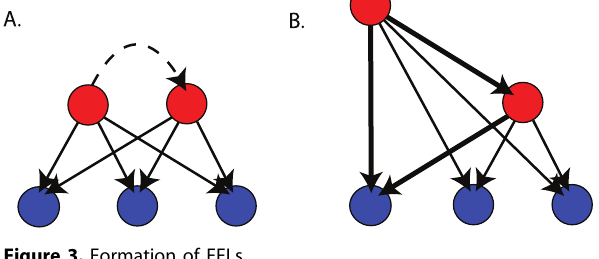
Figure 3. Formation of FFLs (A) Bi-fan array containing three individual bi-fan motifs. (B) Formation of a regulatory interaction between the two transcription regulators generates a feed-forward array containing three FFL motifs (a single example is highlighted in bold).